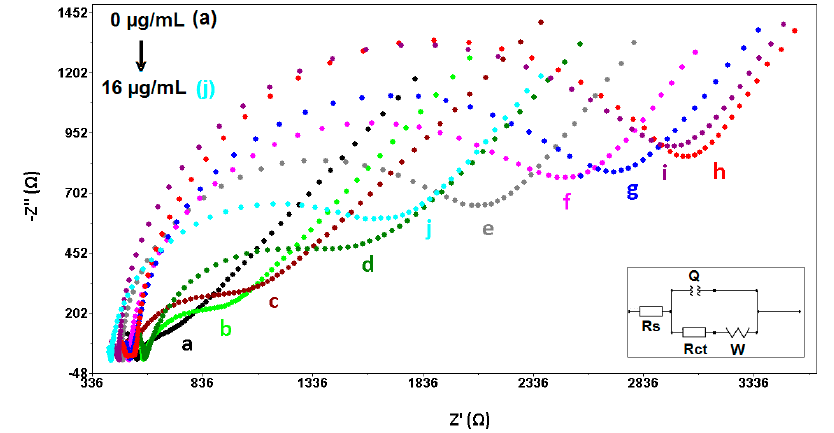
Figure 2. Nyquist diagrams related to ( a ) electrode control, ( b ) 1.0 µ g mL − 1 Z-probe in the absence of target, the hybrid form of Z-probe and ( c ) 2.0, ( d ) 4.0, ( e ) 6.0, ( f) 8.0, ( g ) 10.0, ( h ) 12.0, ( i ) 14.0, ( j ) 16.0 µ g mL − 1 mutant type DNA target.